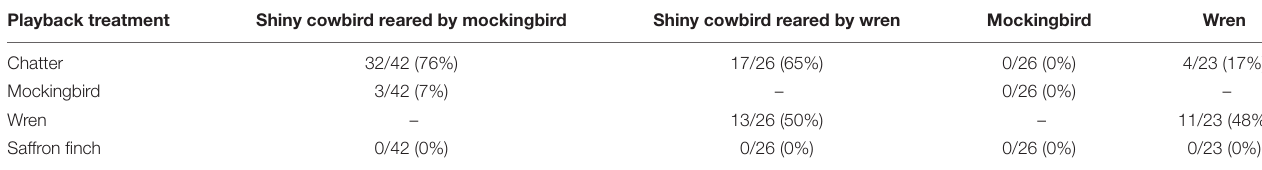
TABLE 1 | Number of nestlings of each chick category that begged over the total number of nestlings for the different playback treatments. Playback treatment